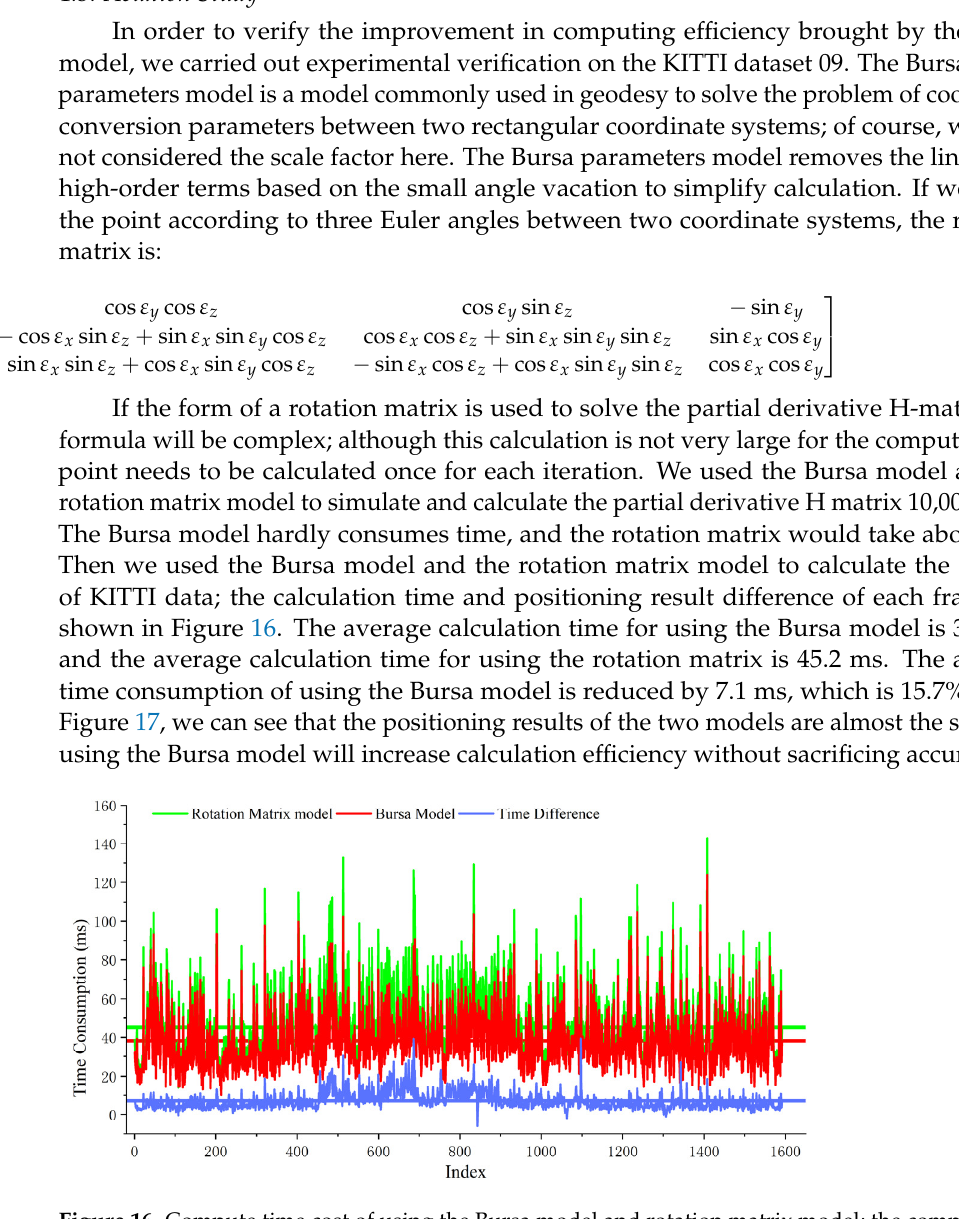
Figure 16. Compute time cost of using the Bursa model and rotation matrix model; the compute time difference between them is the blue line.